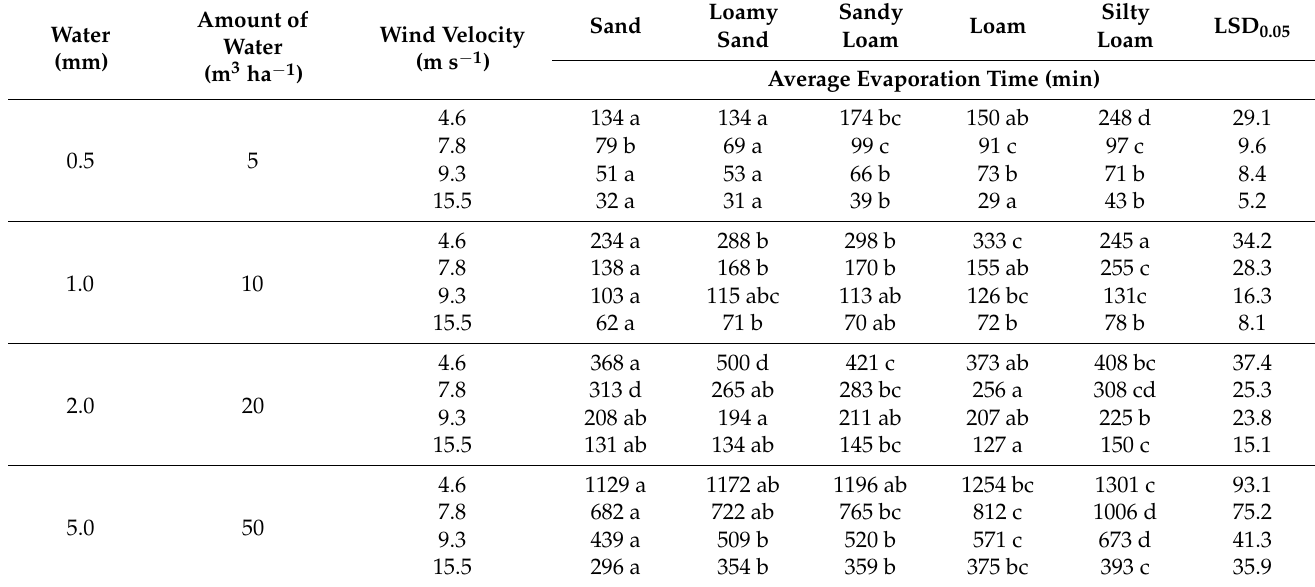
Table 3. The average evaporation time in five soil texture categories in the studied watering levels and wind velocities. LSD 0.05 : LSD t -test was used to separate the soil texture categories at p = 0.05 within each wind velocity and each water amount treatment. Different letters next to the values indicate significant differences within the rows among the five soil texture categories within each wind velocity and each water amount treatment.